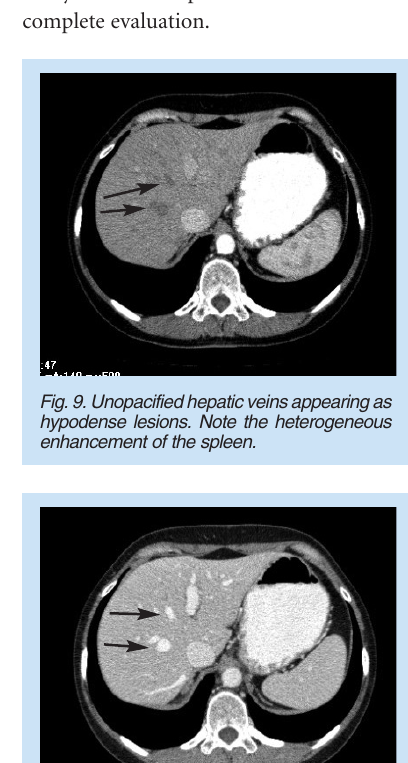
Fig. 7. Pseudothrombus in the IVC.